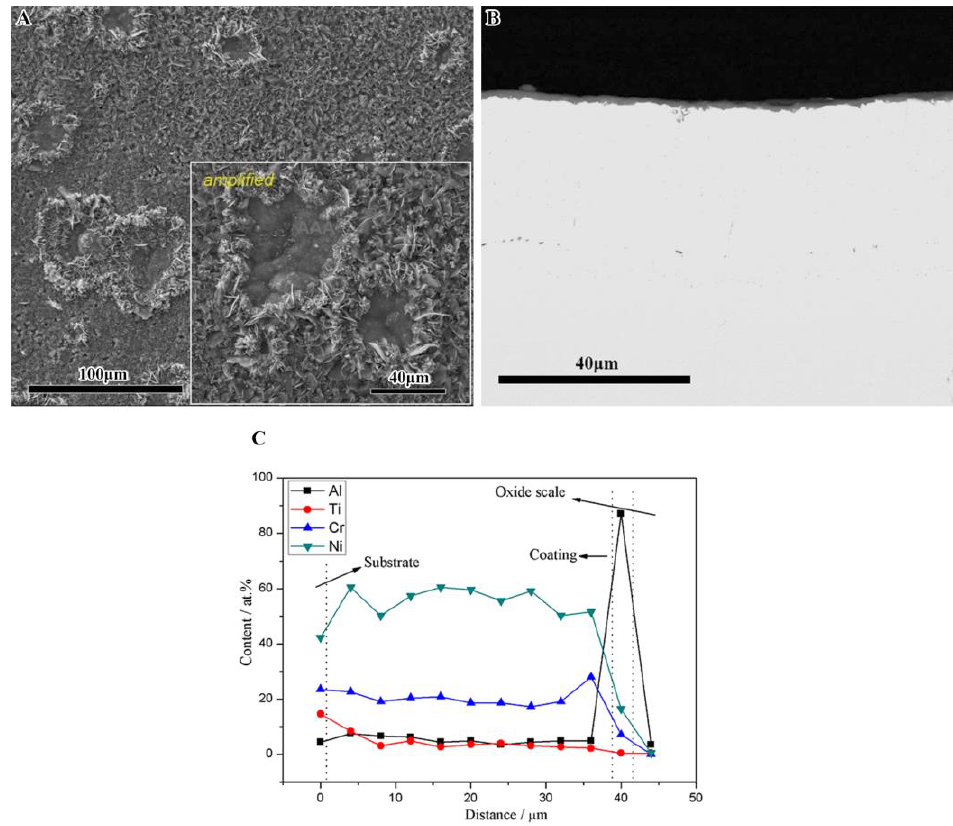
Figure 8. Microstructures of SN-N5 nanocrystalline coatings after oxidation at 1050 °C for 500 h: ( A )surface and ( B ) cross-section morphologies; ( C ) the elemental distribution in depth by EDS line-scanning at the interface plot in ( B ).